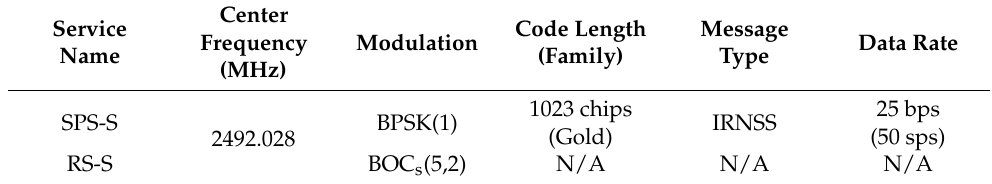
Table 2. Signal design parameters of the S-band Navigation with Indian Constellation (NavIC)